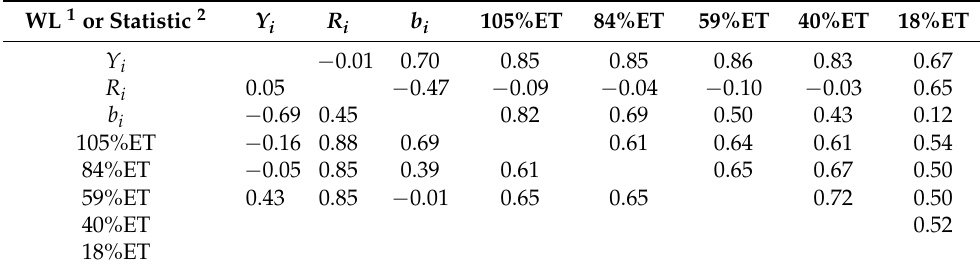
Table 5. Spearman’s Rank correlations among water levels (% ET replacement) and yield statistics for 28 tall fescue half-sib families evaluated for forage mass in a line-source irrigation experiment with 5 water levels (WL) from 2001 to 2003 near Logan, UT, USA. Top diagonal is seasonal total model, and bottom diagonal is across harvests model.